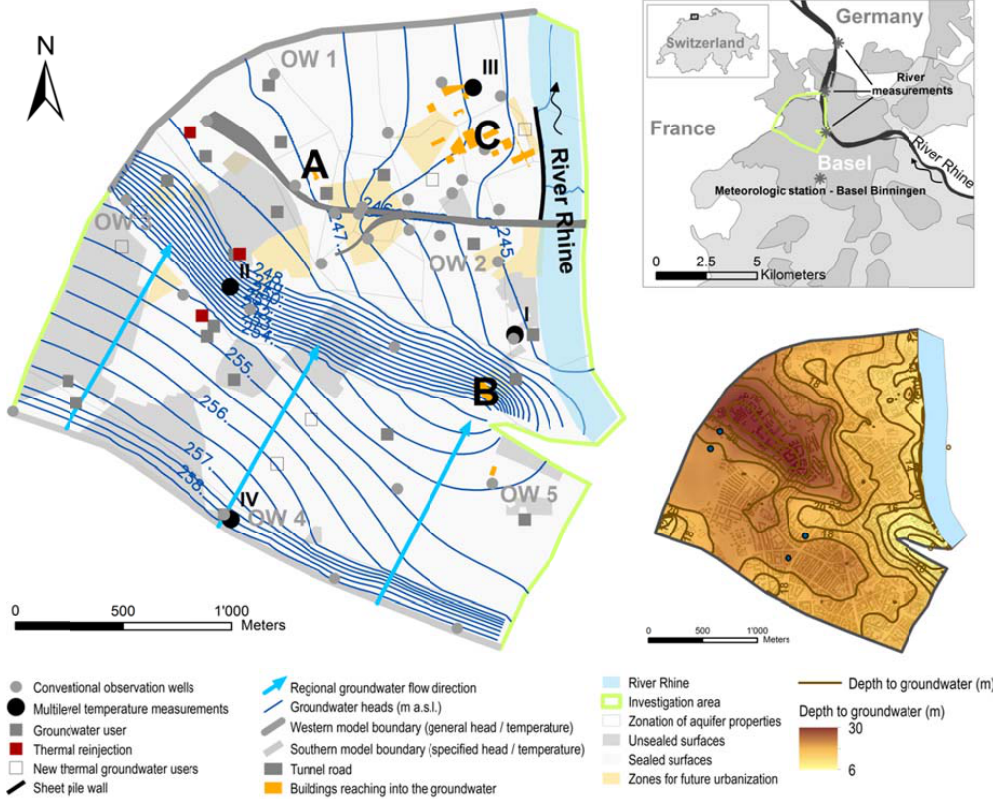
Fig. 1. Left panel: study area including model boundary conditions for flow and heat transport. OW1-5: data from conventional observation wells. I–IV : locations of multilevel temperature measurements. A : Waste incineration facility; B : Biozentrum; and C ; Northern industrial area. Also shown is the regional groundwater flow regime with the main flow directions. Note the steep hydraulic gradient in the center of the modeling domain resulting from the progression of the bedrock as well as the backwater effects along the tunnel road and sheet pile wall. Upper right panel: location of the study area in Switzerland and in the agglomeration of Basel. Lower right panel: depth from the surface to an average groundwater table ranging between 6 and